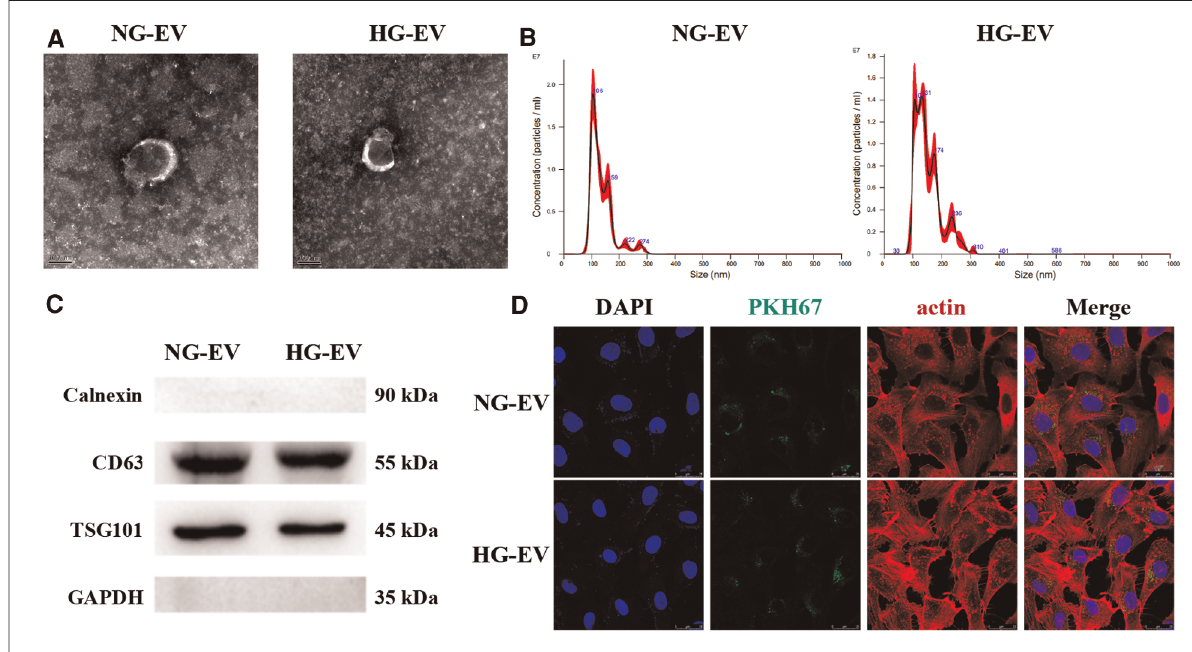
FIGURE 1 Characteristics of EVs. ( A ) Ultrastructure of EVs, scale bar=100 nm. ( B ) Particle size distribution measured by nanoparticle tracking analyzer. ( C ) The expression level of CD81, TSG101 and Calnexin measured by western-blot. ( D ) Uptake assay. The membrane of EVs were labeled with PKH67 (green). HUVECs cytoskeleton was counterstained by actin (red) and nucleus was labeled by DAPI